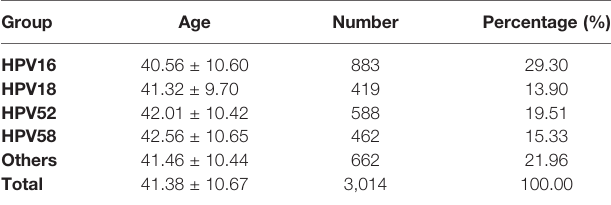
TABLE 1 | Age distribution of HPV subtype groups.